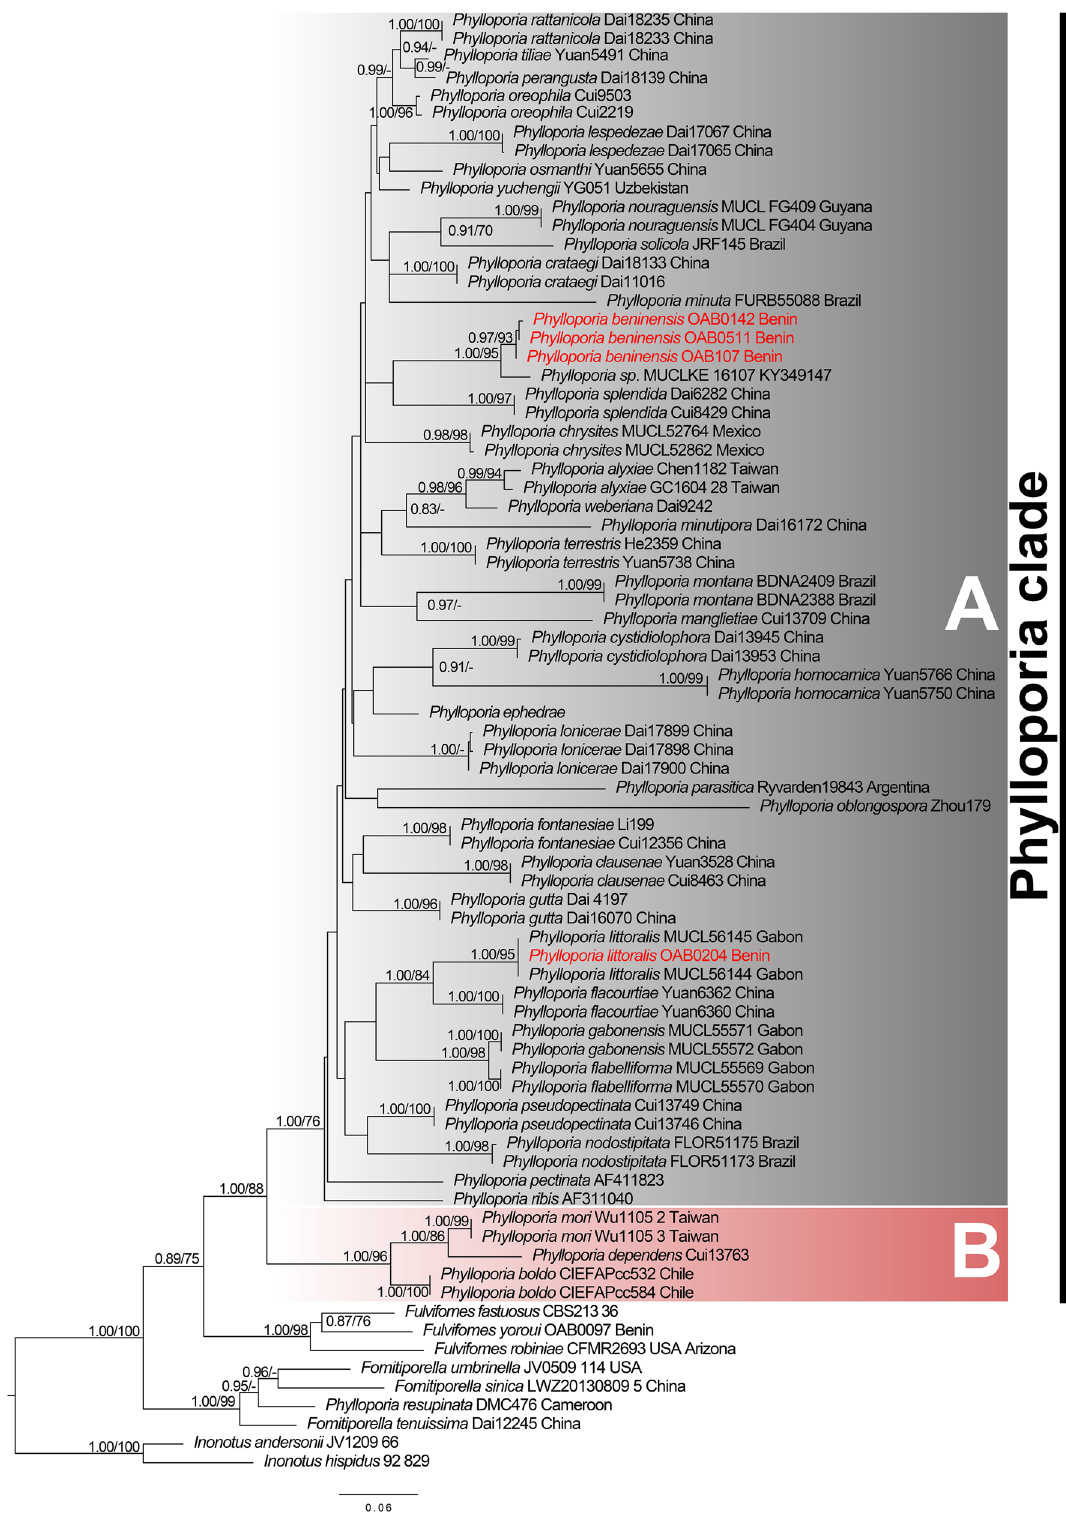
Figure 3. Bayesian analysis (BY) and maximum likelihood (ML) analyses of the combined ITS-LSU dataset of Phylloporia . Branch support values given as PP/BS. Newly generated sequences are highlighted in red. The sequence names are followed by voucher or strain number and country of